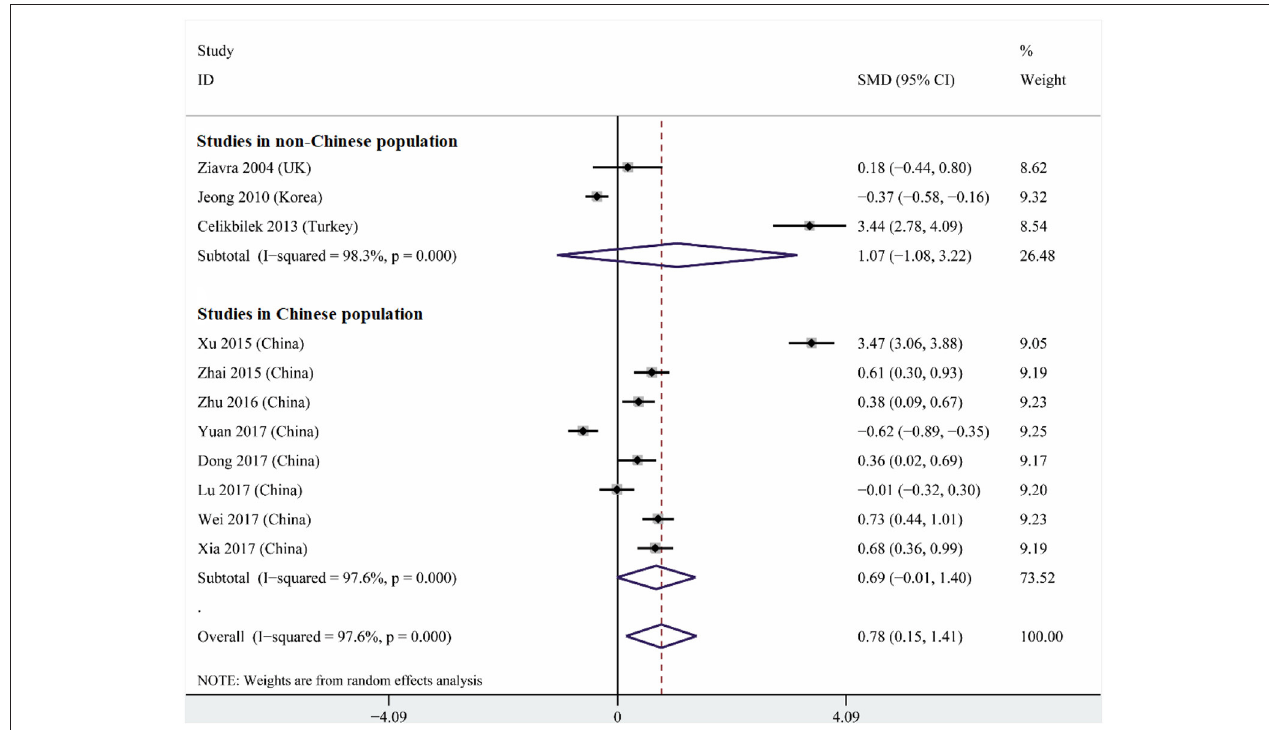
FIGURE 2 | Forest plot of serum uric acid levels in the BPPV and control groups across all studies, in the subset of studies conducted within China or in the subset conducted outside China. The x-axis shows the 95% confidence interval. SMD, standard mean difference.